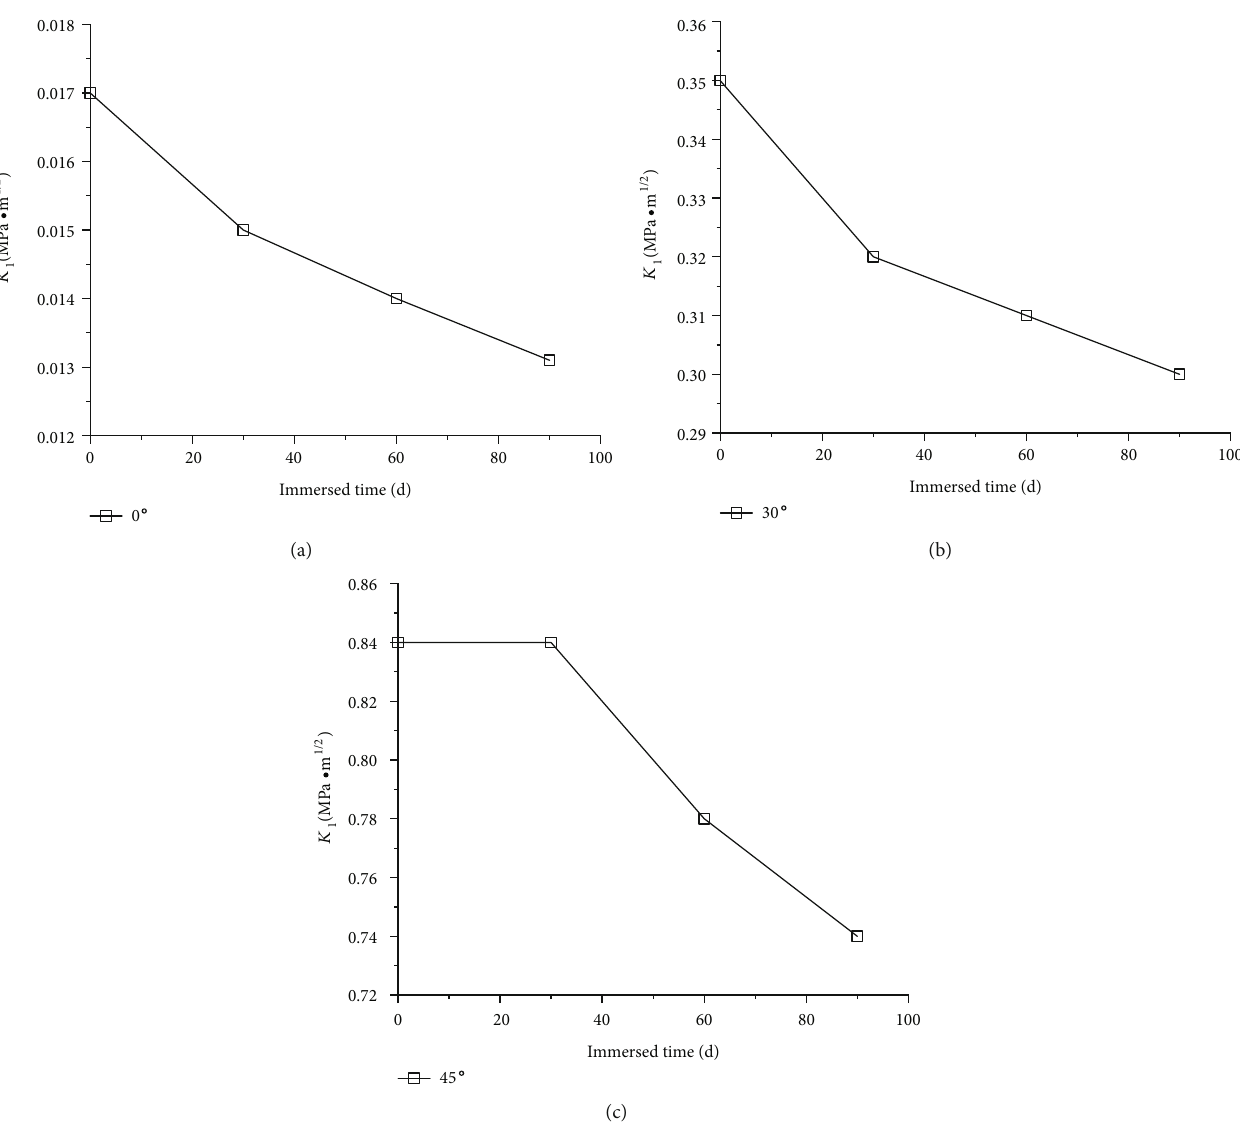
Figure 14: Variation of K 1 under the action of chemical